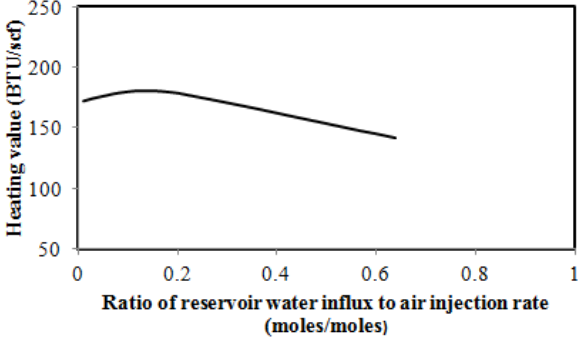
Figure 18. Effect of reservoir water influx on heating values of gas [45].